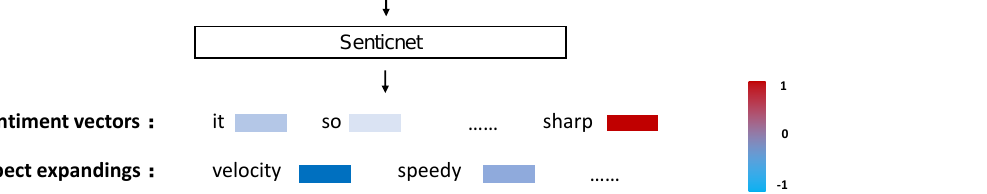
Figure 2. Sentiment vectors and aspect supplementary based on SenticNet. The different colors and shades represent the emotional polarity score of the word in SenticNet, where − 1 is negative and 1 is